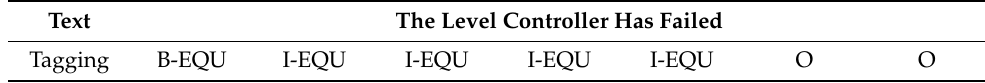
Table 1. A concrete example of data labeling.